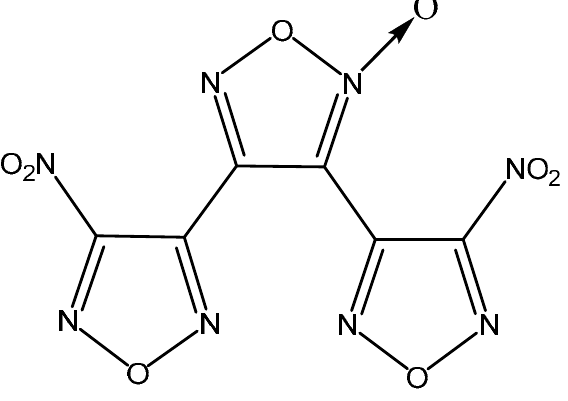
Figure 9. Schematic diagram of molecular structure for DNTF.